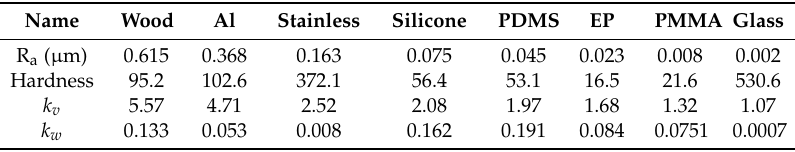
Table 2. Properties of eight common flat material